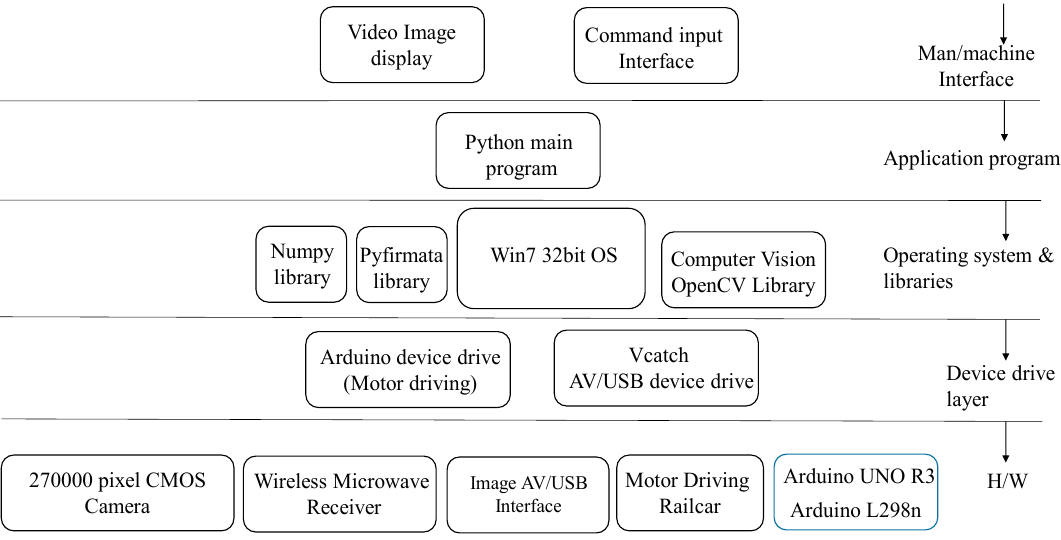
Figure 5. Integrated system architecture.